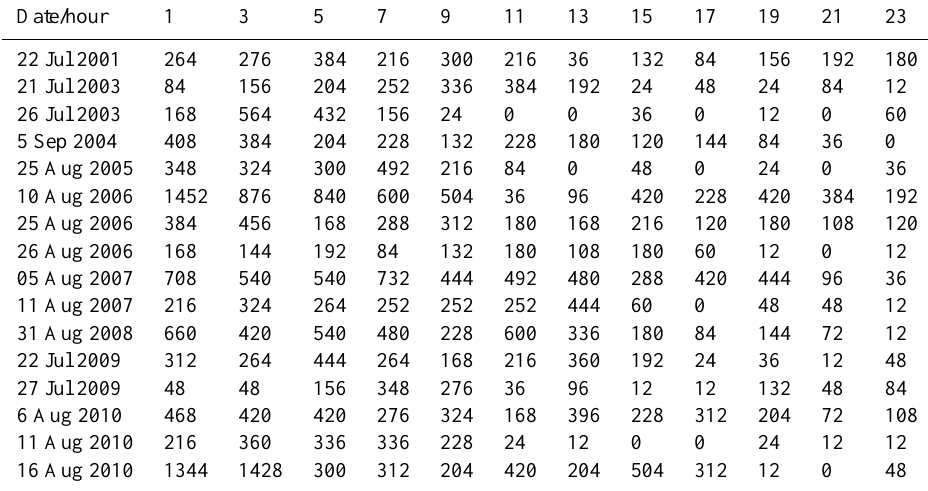
Table 2. Days with episodes (above 100sporesm − 3 ) of fungal spores with a markedly different daily pattern compared to the overall daily pattern of the 232 episodes recorded in Copenhagen during